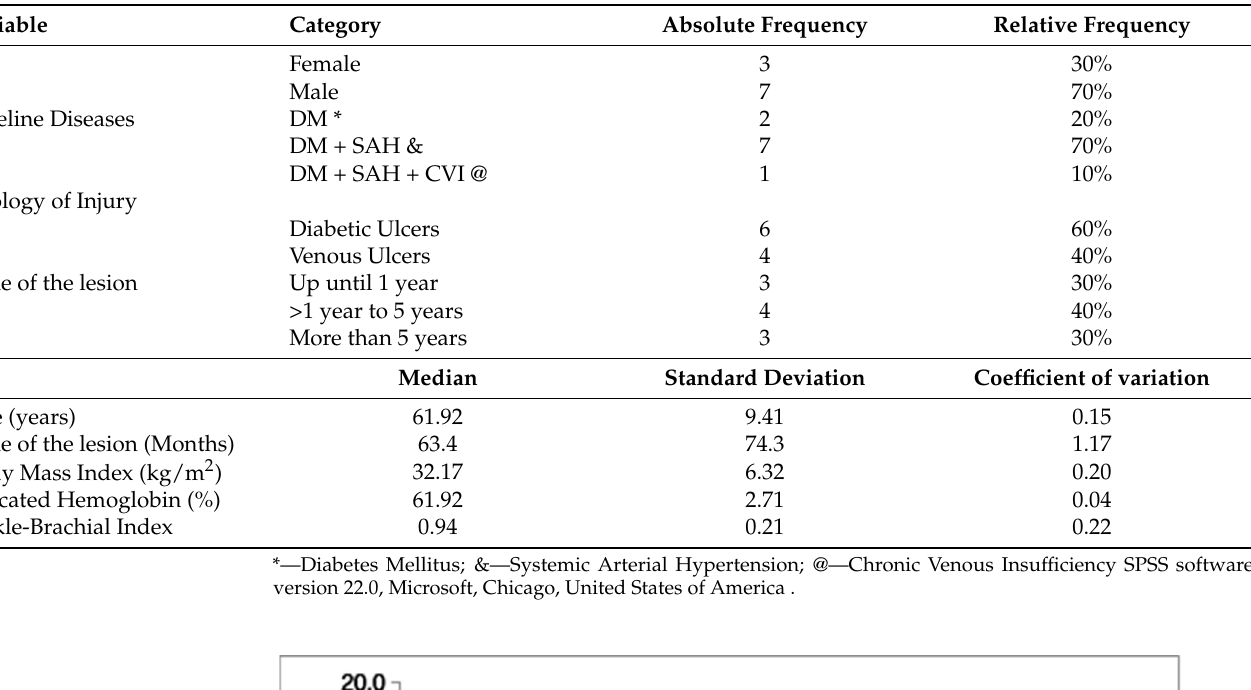
Table 2. The main statistics for the absolute reduction and relative reduction of the ulcer area.